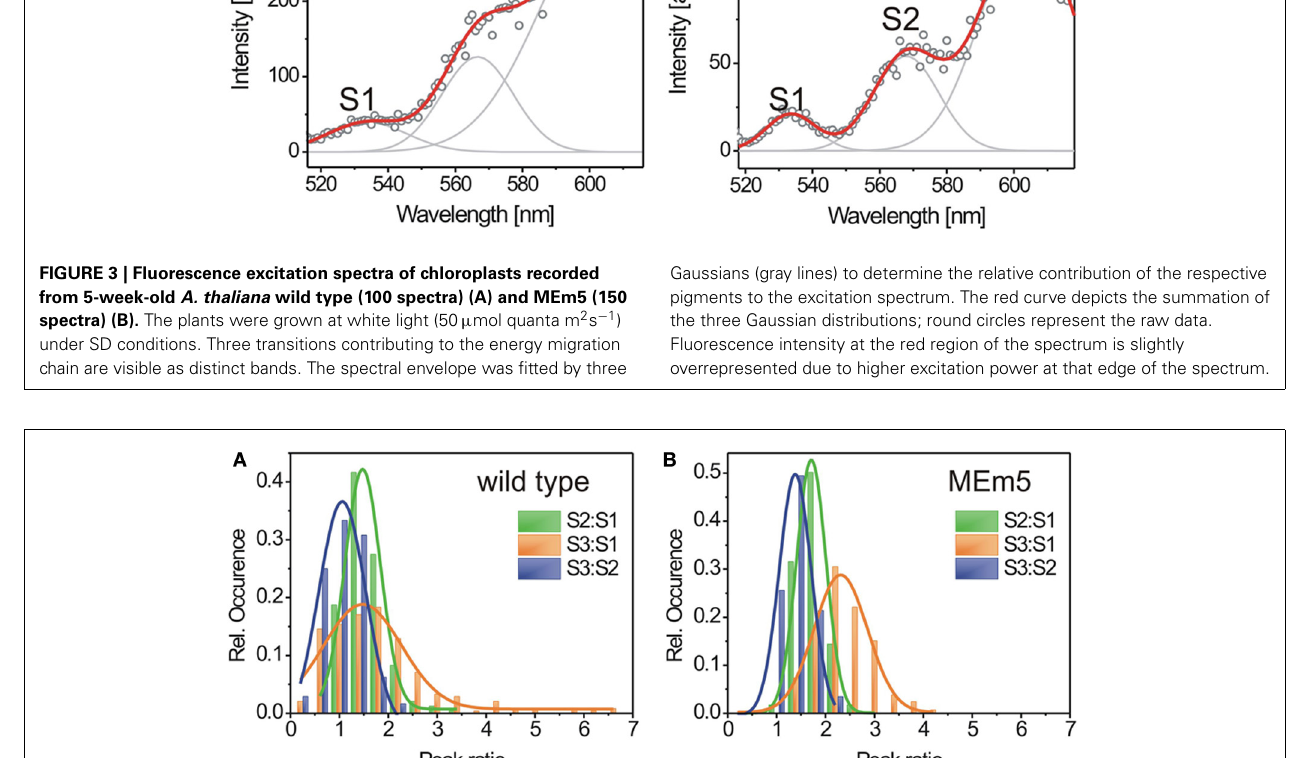
FIGURE 4 | FExS reveals characteristic composition for different carotenoids of the LHCs in chloroplasts of A. thaliana wild type (A) and MEm (B) plants. Every FExS spectrum was fitted by three Gaussians and the area under the peaks was calculated relative to the peak representing the